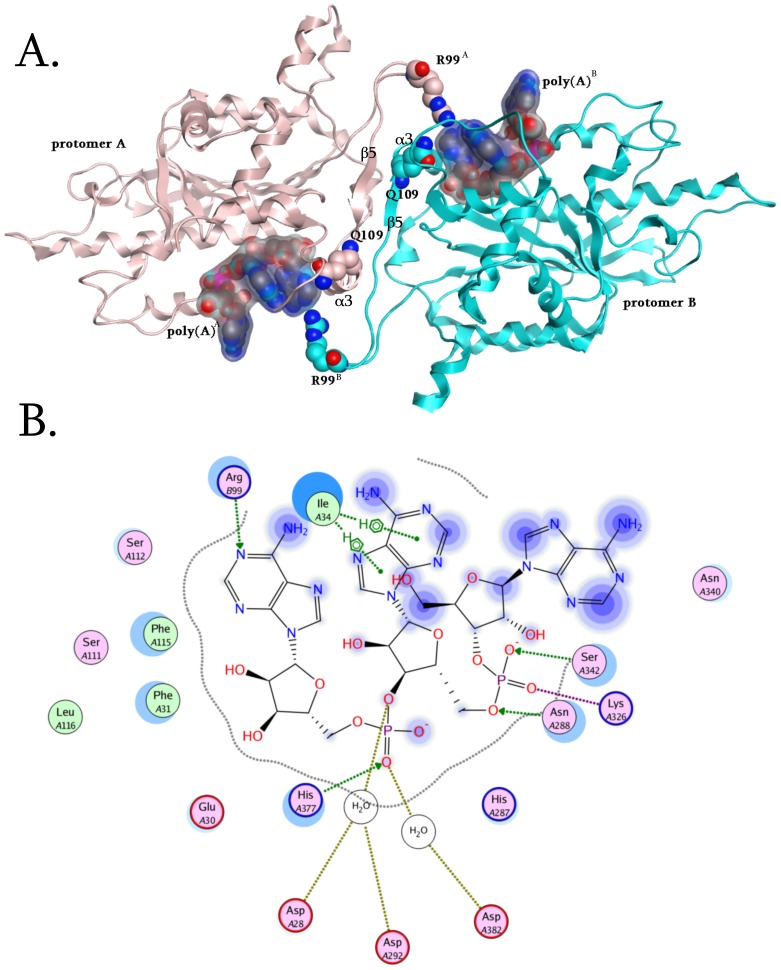
The role of Arg99 in the catalytic mechanism of PARN.(A) PARN - Poly(A) interactions have been calculated for both active sites. The Arg99 residues have been highlighted while they are H-bonding with the base moiety of the first poly(A) nucleotide. (B) The interaction map of poly(A) and the catalytic site of human PARN, showing the water mediated bridges of the Aspartic residue attacking the first phosphodiesteric bond, and the vital contribution of the invariant, structurally conserved His377 residue.